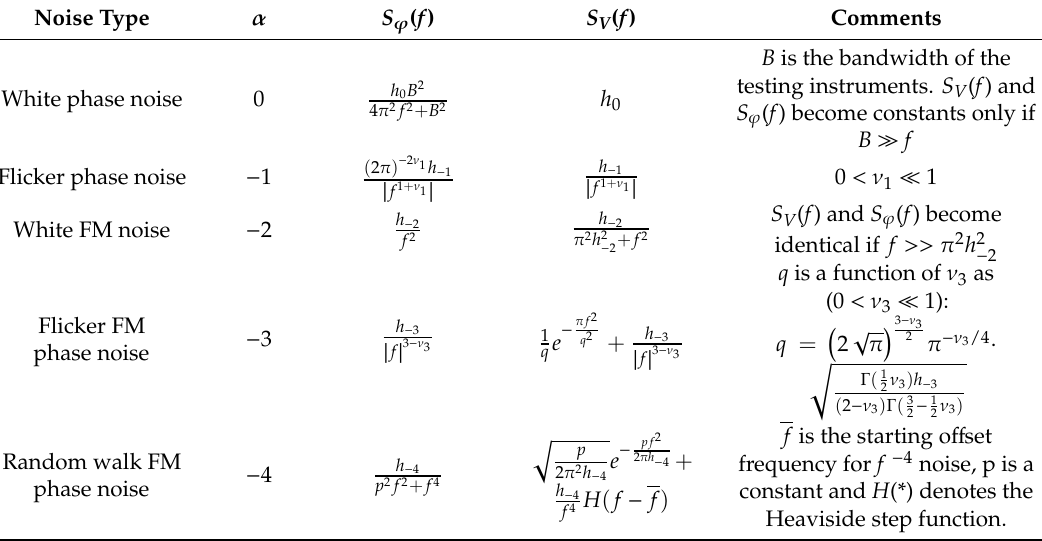
Table 1. The power law phase noise occurs in S V ( f ) and S ϕ ( f )